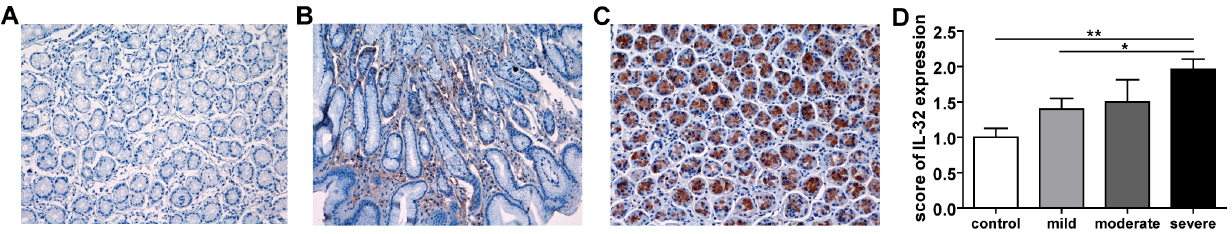
Figure 2. IL-32 protein was detected in the gastric biopsy tissues. A. control isotype IgG (200 6 ); B. A representative microphotograph showing biopsy sections from H. pylori -negative normal controls stained for IL-32 (200 6 ); C. A representative microphotograph showing IL-32 immunostaining in biopsy sections from H. pylori -positive patients (200 6 ) ; D. The immunohistochemistry of IL-32 in the gastric biopsy tissues was semi-quantitatively graded as scores (0=no expression; 1=low expression; 2=intermediate expression; 3=high expression). * P , 0.05; ** P , 0.01.